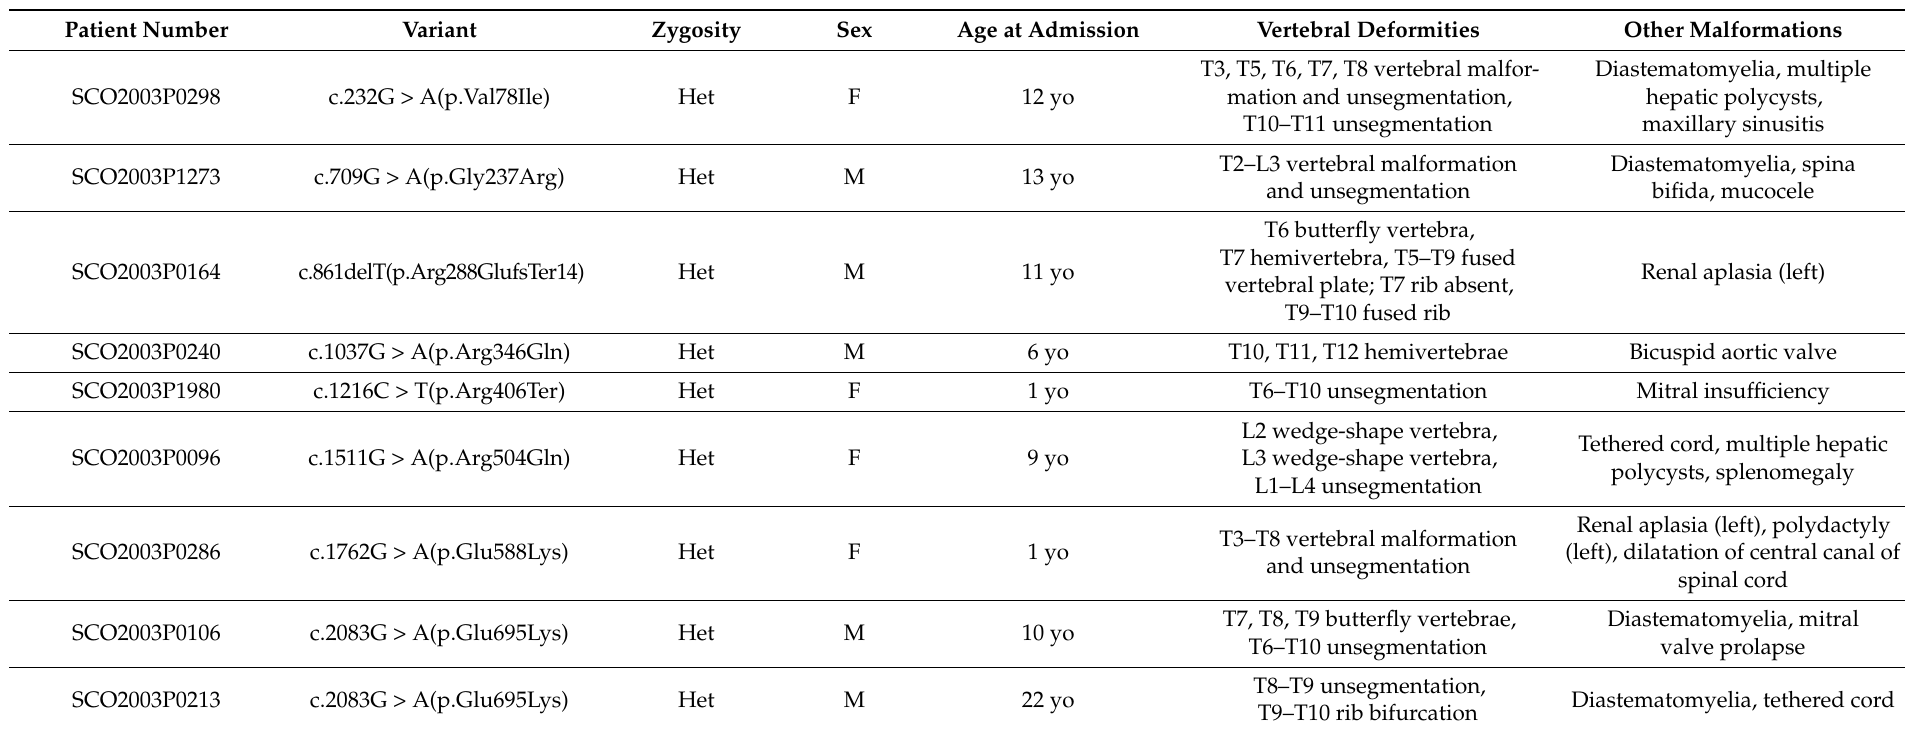
Table 1. Summary of clinical features of the NADSYN1 variant carriers from the DISCO cohort. Patients were diagnosed with congenital scoliosis presenting with vertebral deformities and other malformations. The RefSeq transcript sequence of the NADSYN1 gene is NM_018161.5. Abbreviations: Het, heterozygous; M, male; F, female; yo, years-old; T, thoracic vertebra; L, lumbar